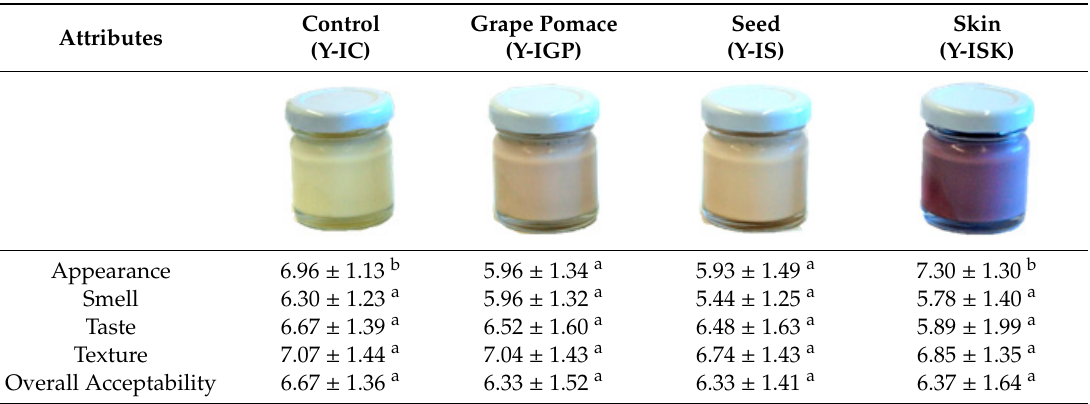
Table 5. Pilot consumer analysis ( n = 30) of yogurts containing inulin-type fructans and winery byproduct extracts.